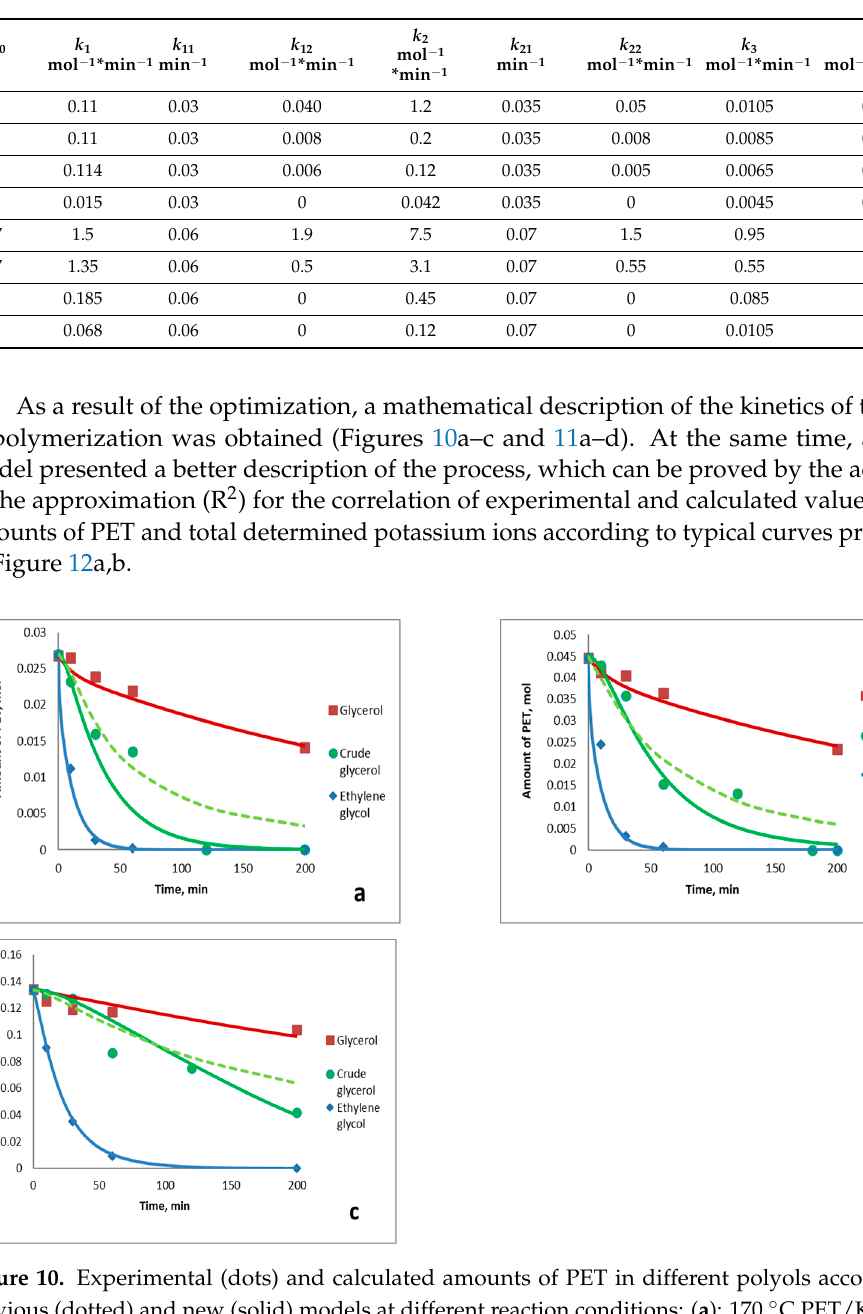
Table 3. Parameters of Equations (4)–(15) for PET depolymerization by crude glycerol.